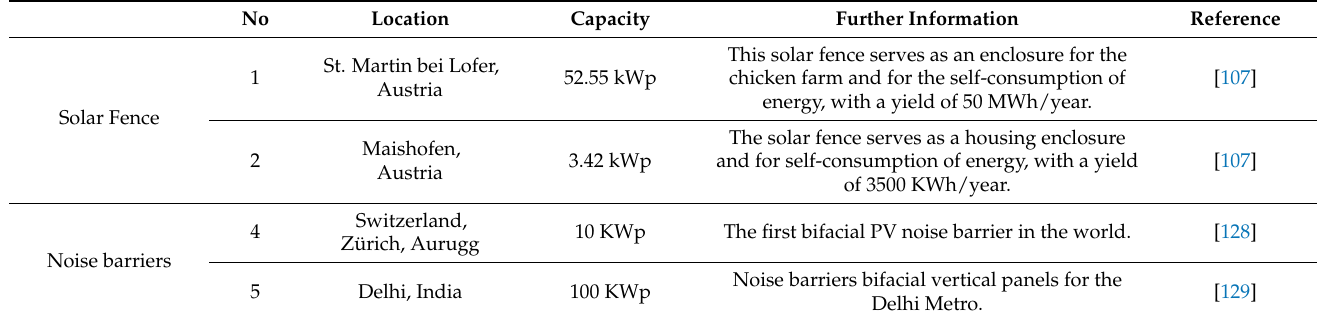
Table 3. Examples of installations of solar fences and noise barriers with bifacial photovoltaic modules.